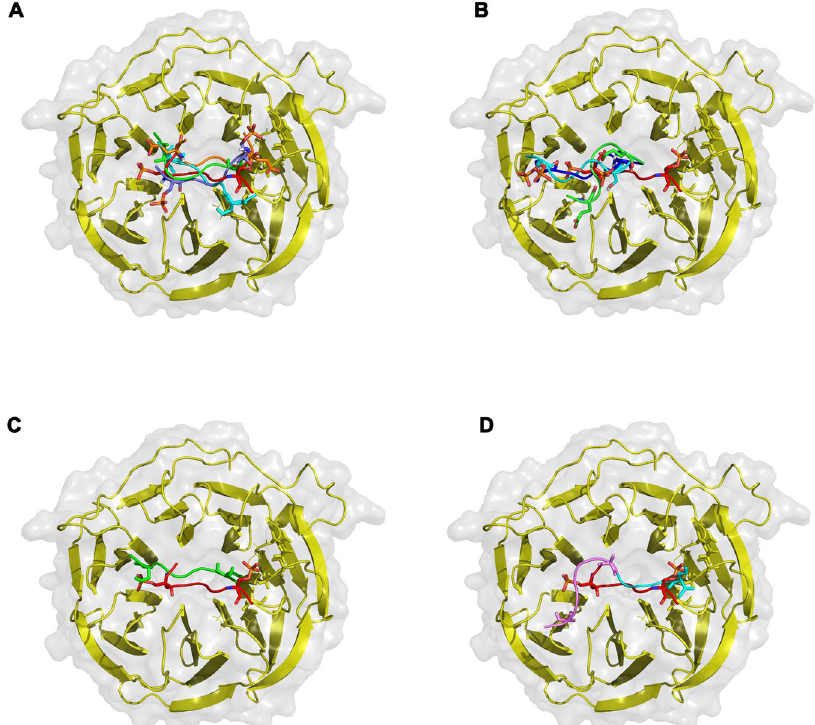
Figure 7. The interaction of PHF10 phosphodegrons with β -TrCP. ( A ) Selected conformations of Peptide-1 variants. Reference β -catenin peptide (PDBid 1P22) is colored red; unphosphorylated variant (Peptide1- Normal) - light blue, Ser-Ala variant (Peptide1-A) - green; phosphorylated variant (Peptide1-P) – violet, Ser- Gln mutated variant (Peptide1-E) – orange. Difference between the reference β -catenin peptide (red) position on the surface of the β -TrCP enzyme and selected conformations of ( B ) single phosphorylated (Peptide2-P1, light blue), double-phosphorylated (Peptide2-P2, blue) and Ser-Gln (Peptide2-E, green) variants of peptide-2; ( C ) unphosphorylated peptide-2 variant (Peptide2-Normal, green); ( D ) Ser-Ala mutated variant (Peptide2-A, violet), C- terminus sequence PPDS, containing Ser16 residue is highlighted